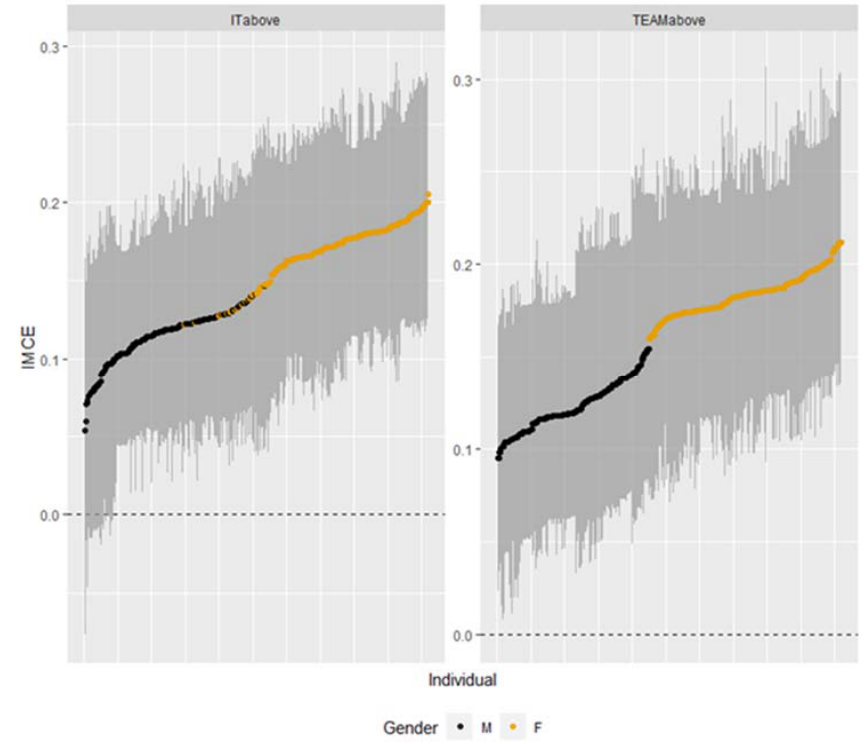
Figure 7. Heterogeneity in IMCE’s by the gender of the respondent.